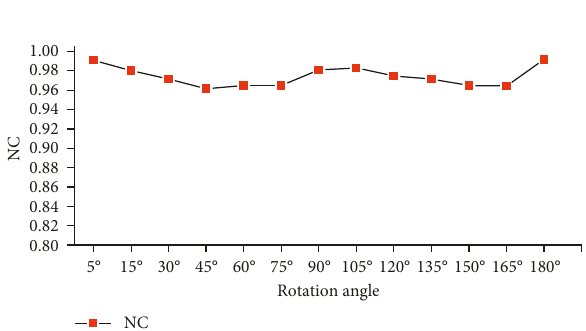
Figure 12: NC mean under shear attack.